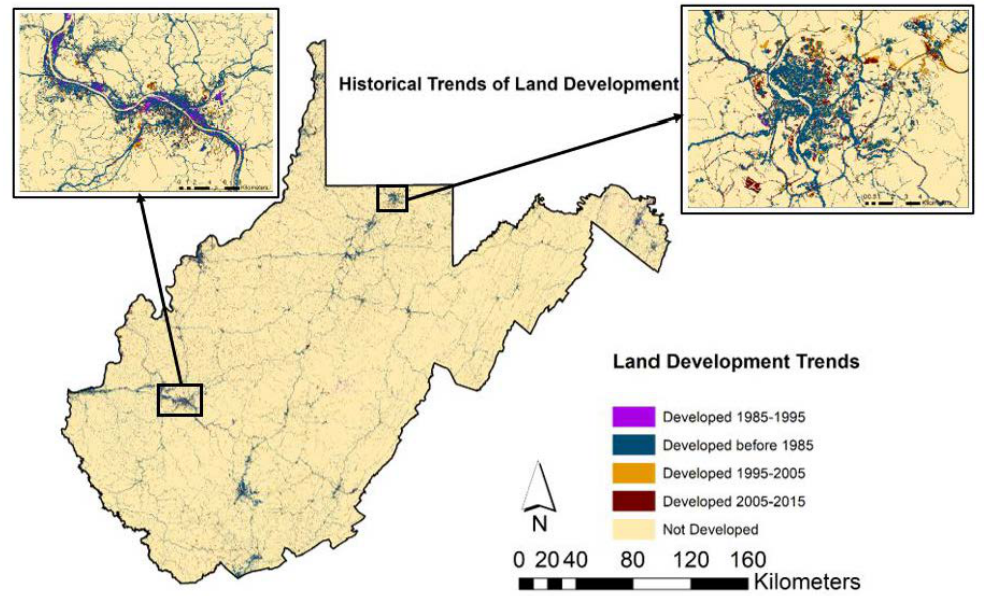
Figure 4. Land development trends in the WV: the right magnified region is Morgantown city, home of West Virginia University and the left on is Charleston, WV’s capital city. These cities are the two most populated MSAs of WV [35].